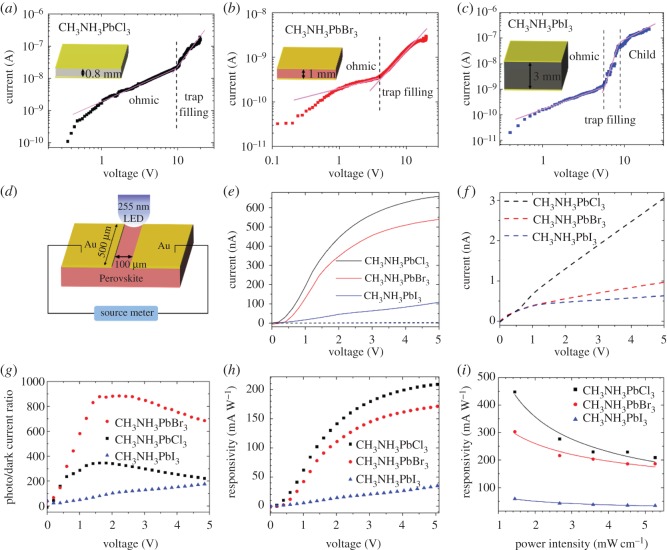
Current versus voltage in logarithmic coordinates (logI–logV) under dark condition of sandwich structure (a) CH3NH3PbCl3, (b) CH3NH3PbBr3, and (c) CH3NH3PbI3 devices, which show different regions marked as ohmic (I ∝ V), trap filling (I ∝ V3), and Child (I ∝ V2). The insets show the diagram of device structure. (d) Schematic diagram of planar MSM detectors and photoresponse measurement system. (e) Dark currents (dotted lines) and photocurrents (solid lines) under illumination of 5.3 mW cm−2 255 nm light versus voltage of three planar MSM detectors. (f) Dark current versus voltage (I–V) of three planar MSM detectors. (g) Photo/dark current ratio and (h) responsivity of three CH3NH3PbX3 detectors with varying voltage. (i) The responsivity of three CH3NH3PbX3 detectors with increasing power intensity.